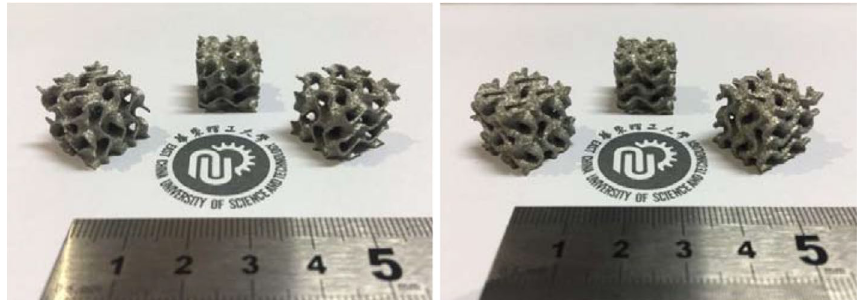
Figure 18. Formed samples of Gyoid complex